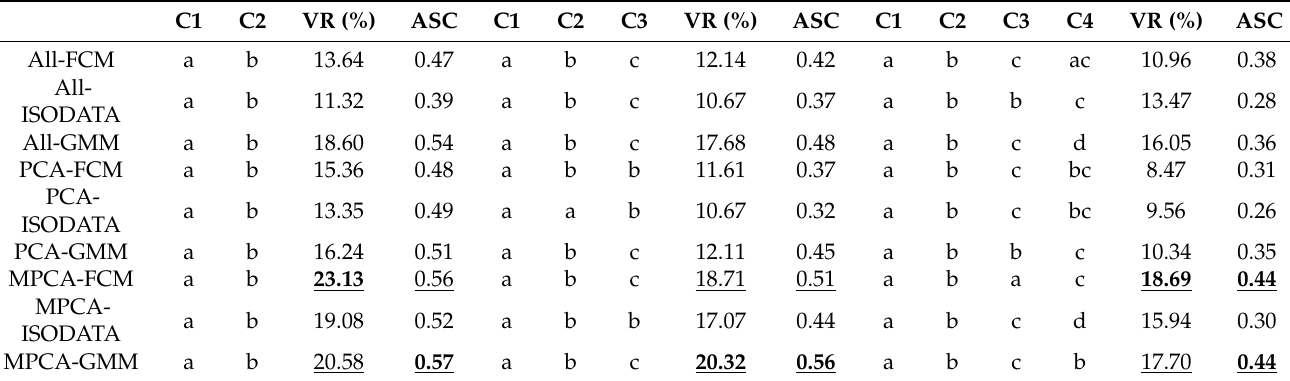
Table 4. Results of the evaluation of the clustering models in the generation of two, three, and four classes in terms of the ANOVA (Tukey’s test), variance reduction (VR) index, and average silhouette coefficient (ASC).